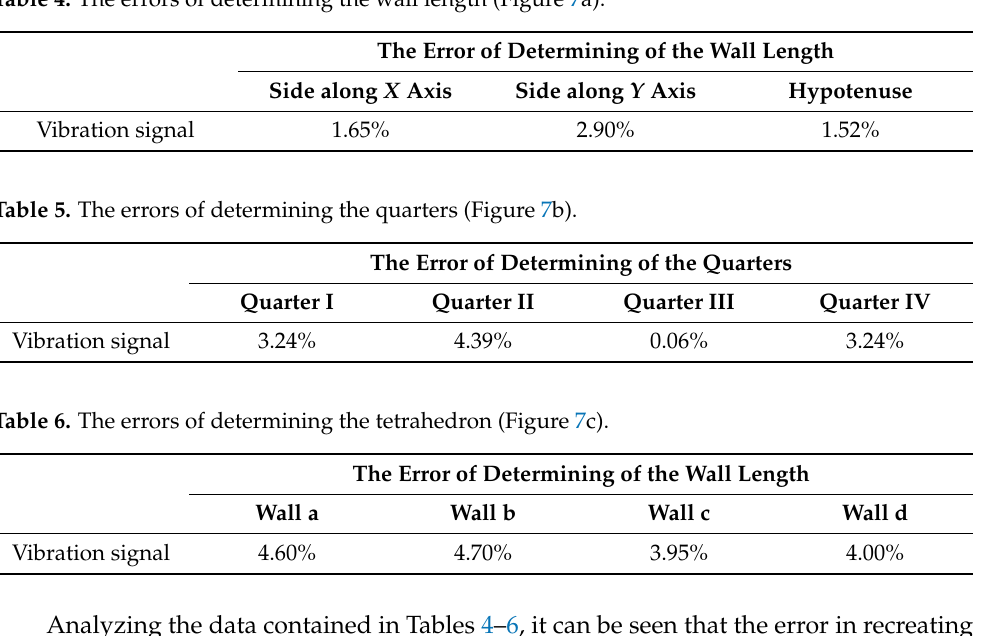
Table 4. The errors of determining the wall length (Figure 7a).